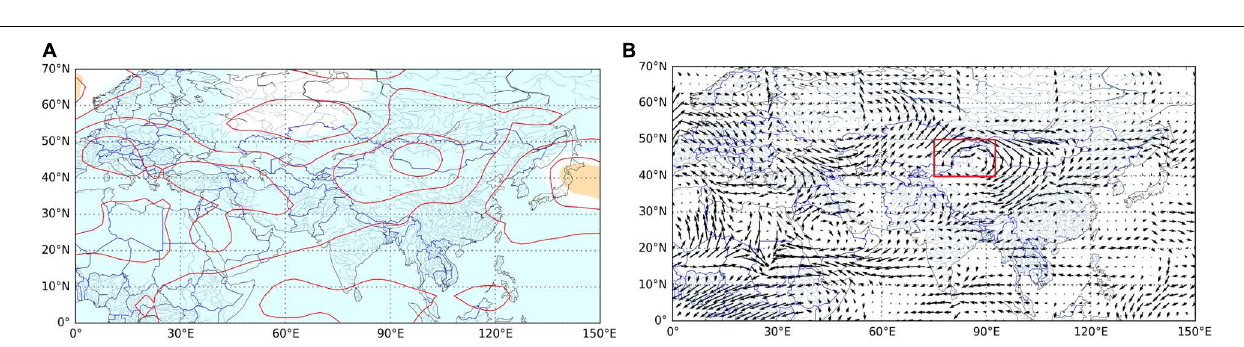
FIGURE 8 | Trends of (A) geopotential height and (B) wind speed at 500 hPa during 1961–2017 (blue, p < 0.01; white, 0.01 < p < 0.05; yellow, p >